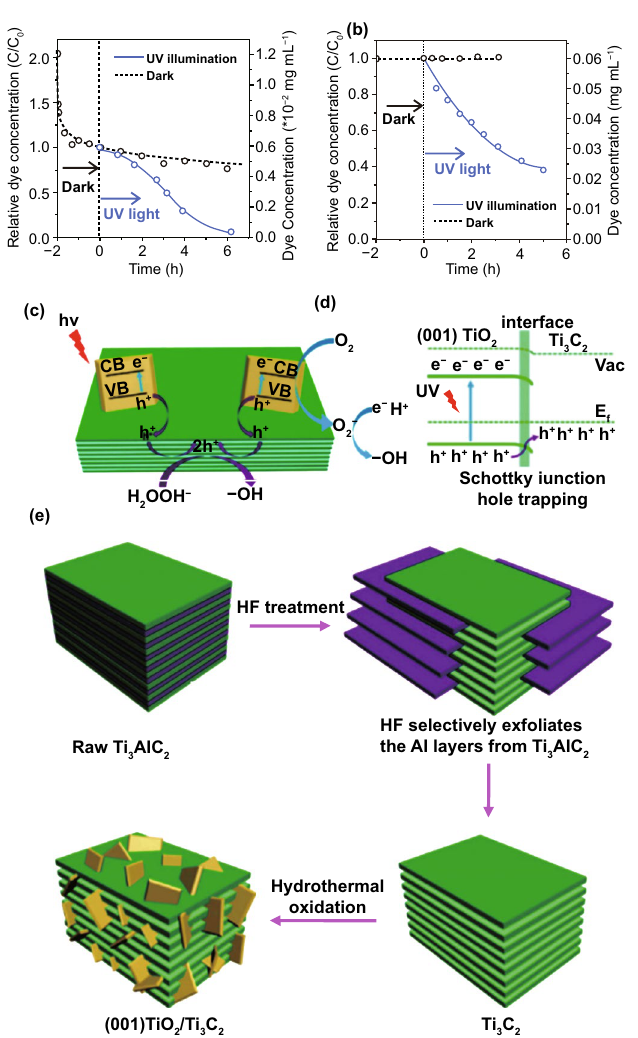
Fig. 22 Photo‑catalytic pollutant degradation utilizing MXenes and their hybrid nano‑composites. a , b Time‑dependent MB respective level ( a ) and AB80 ( b ) in Ti 3 C 2 T x . Adapted with permission from Ref. [135]). c–e Preparation of (001)TiO 2 /Ti 3 C 2 nano‑hybrids ( c ), charge transfer pro‑ cess ( d ), B.G. ( e ) of (001)TiO 2 /Ti 3 C 2 after light irradiation. Adapted with permission from Ref.